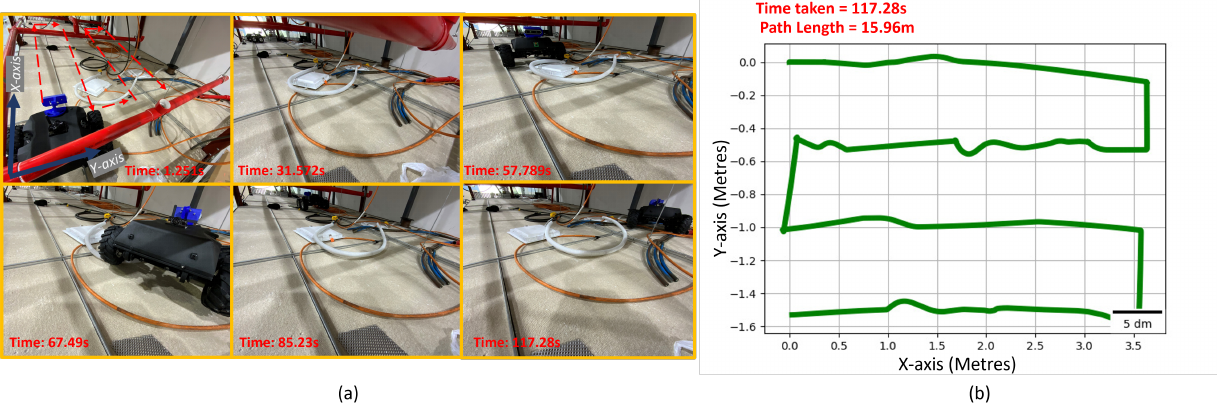
Figure 17. The experiment trial performed in the false-ceiling test-bed for covering 4 × 2 m. ( a ) Robot performing inspection in the false-ceiling test-bed at various time frames. ( b ) Fused odometry plot of the robot during the experimental trial.